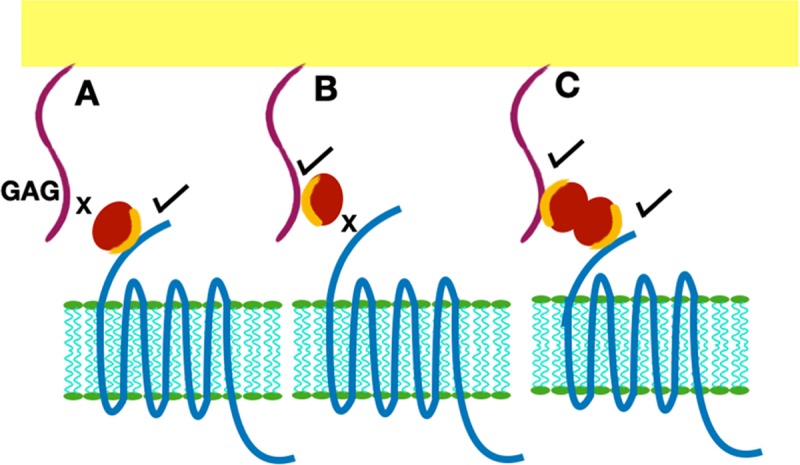
Presentation of GAG-bound chemokine for receptor interactions. Chemokine is shown as a red sphere, and shared residues for GAG and receptor binding are shown in orange. (A) Chemokine monomer bound to the receptor cannot bind the GAG. (B) Chemokine monomer bound to a GAG chain cannot bind the receptor. (C) A chemokine dimer bound to a single GAG chain. In this case, one monomer can bind the GAG and the second monomer of the dimer is available for receptor interactions.